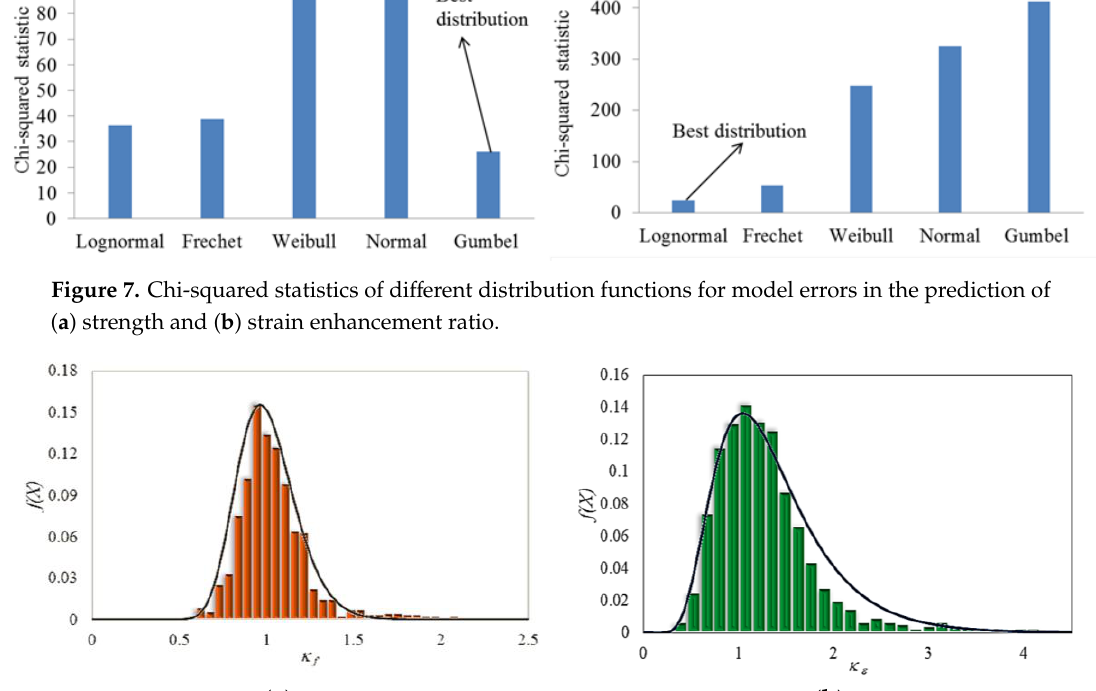
Figure 8. Histogram and best probability density functions for model errors of ( a ) strength ( κ f ) and ( b ) strain ( κ ε ) enhancement ratio.